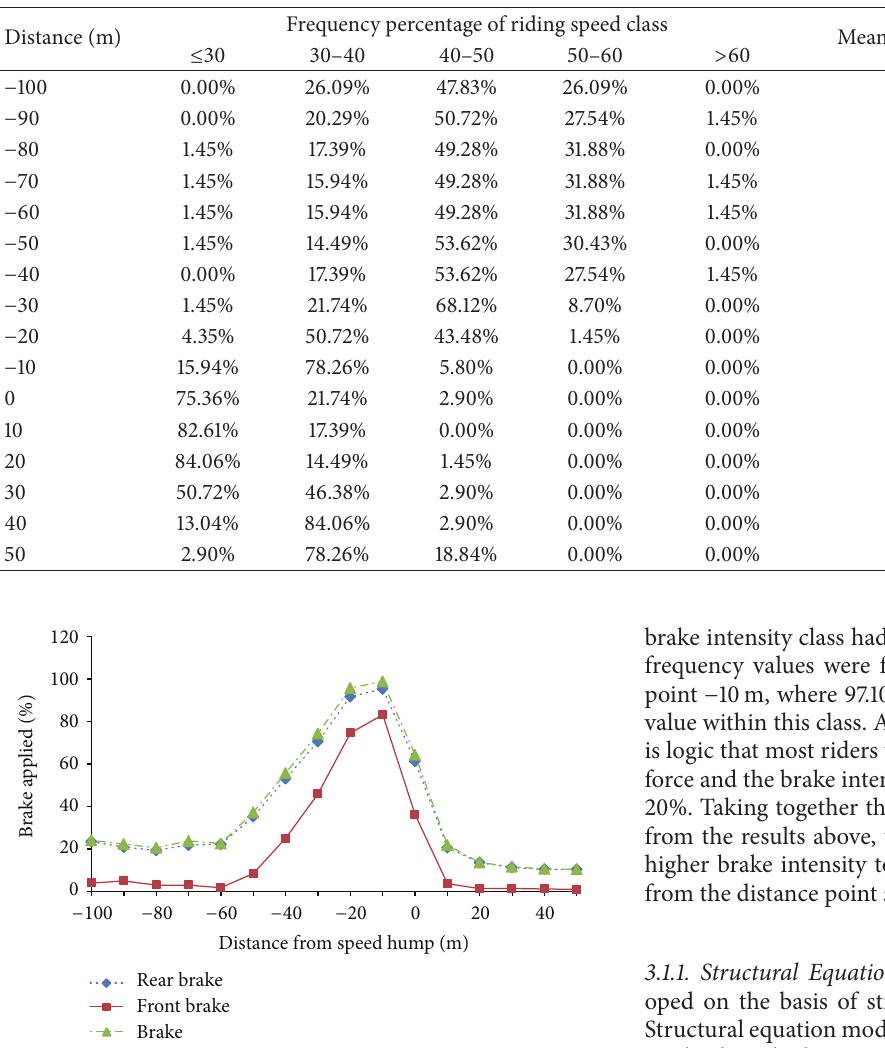
Table 2: Speed class frequency, mean speed, and differences in various distances from speed table.